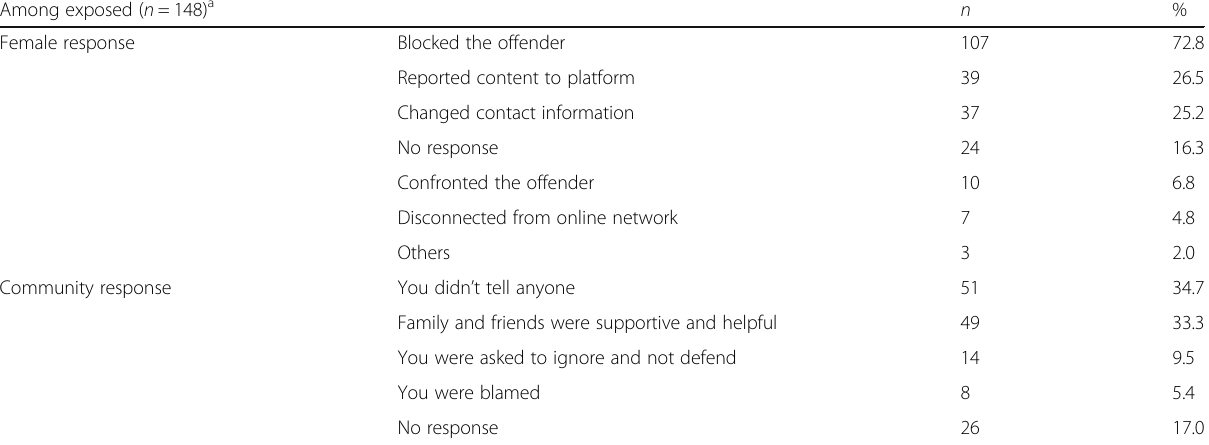
Table 4 Female and community responses to cyber violence incidents ( N = 148) Among exposed ( n = 148)